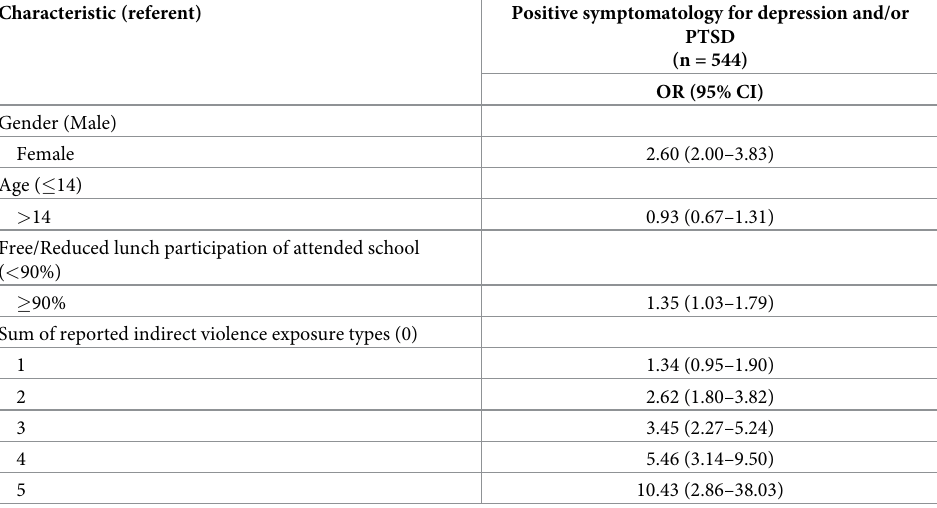
Table 8. Multivariate logistic regression model for any MH outcome (N =